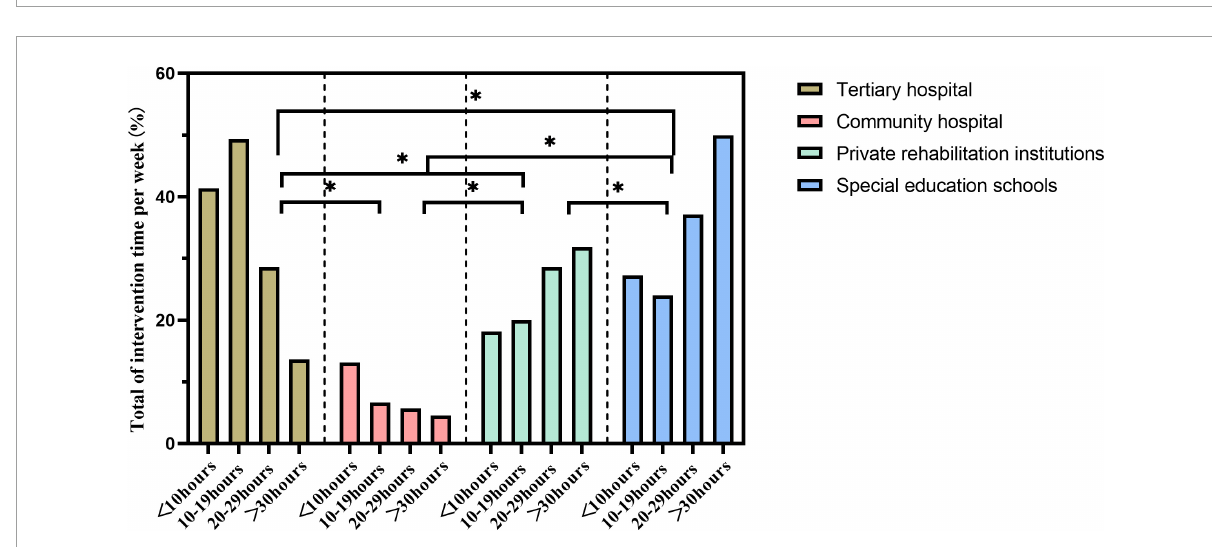
FIGURE3 Influence of rehabilitation location on the total weekly intervention duration for children with Autism spectrum disorder (ASD). * p < 0.05; ns, p >